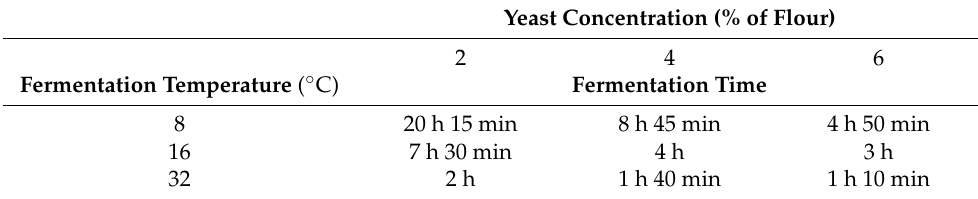
Table 5. Parameters of the fermentation